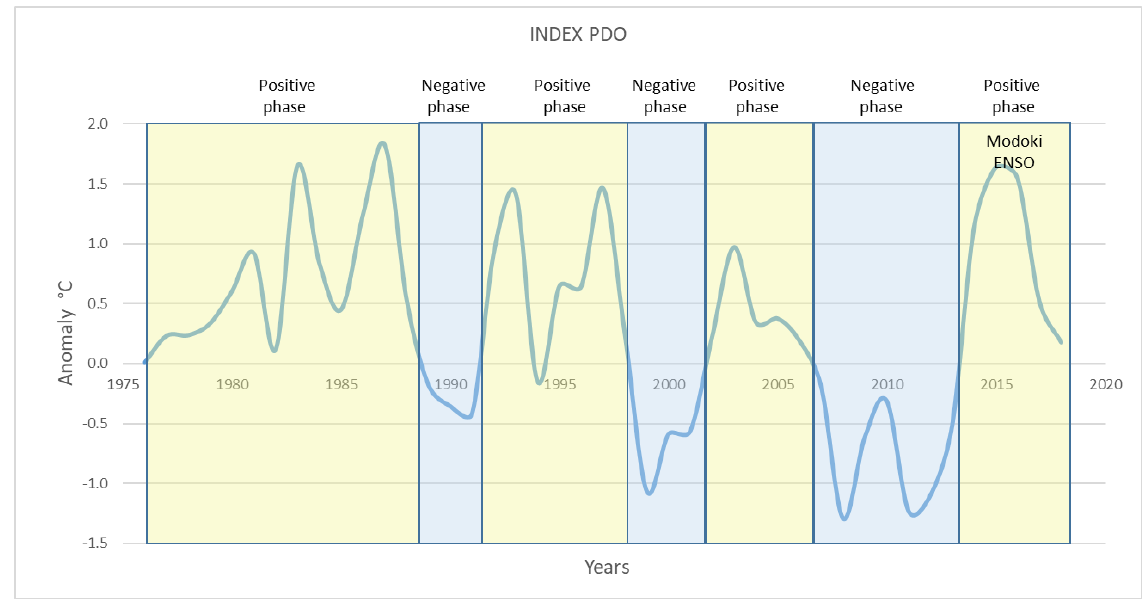
Figure 8. Time series of the phase change in the Pacific Decadal Oscillation (PDO), from 1976 – 2018. The values are annual averages of the anomalies. Positive phases indicate warm years and negative phases indicate cool years.